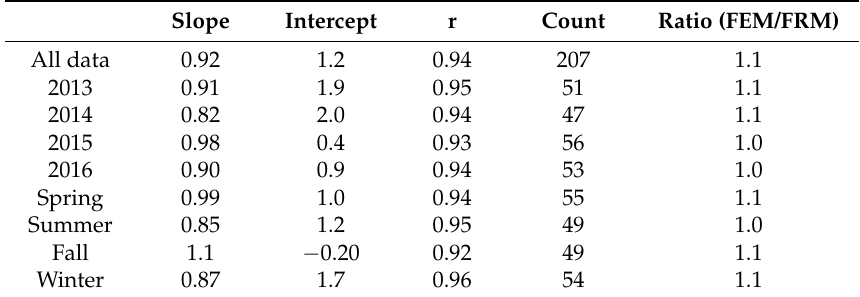
Table 3. Linear regression results of the FEM SHARP 5030 vs the FRM at the Toronto West station. Slope Intercept r Count Ratio (FEM/FRM) All data 0.92